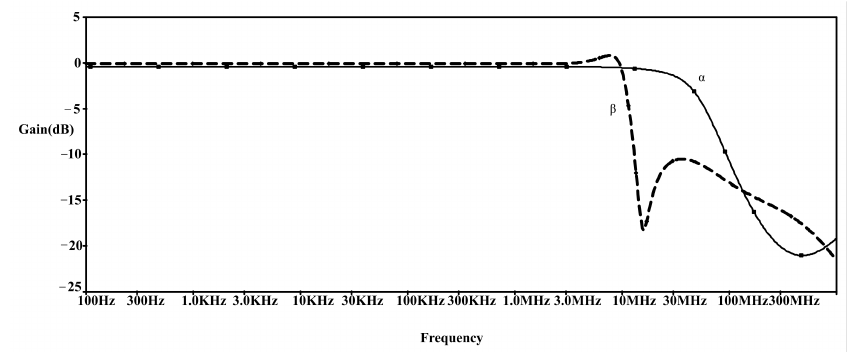
Figure 9. Frequency performance of the β = (I X /I Y ) and α = (Vz/Vx).